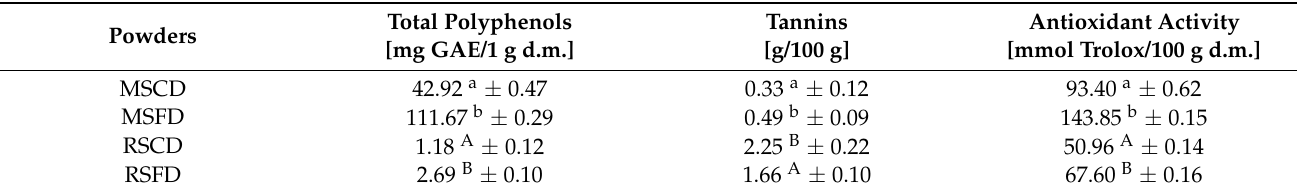
Table 3. Total polyphenol, tannin content and antioxidant activity of mango and rambutan seed powders dried by different